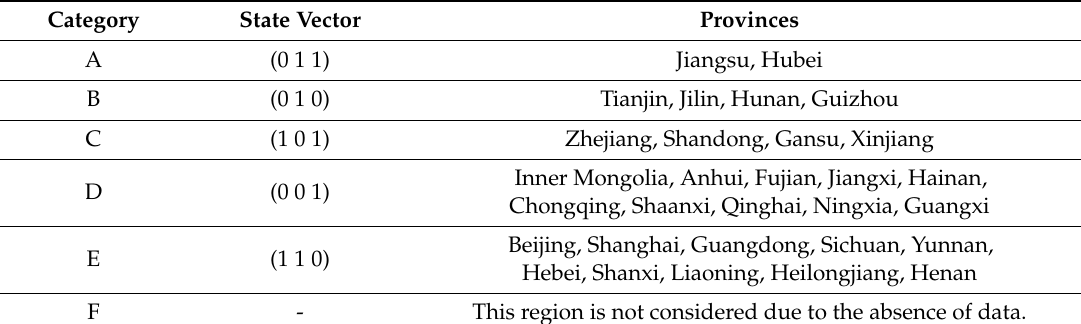
Table A6. Classified results for 30 provinces based on state